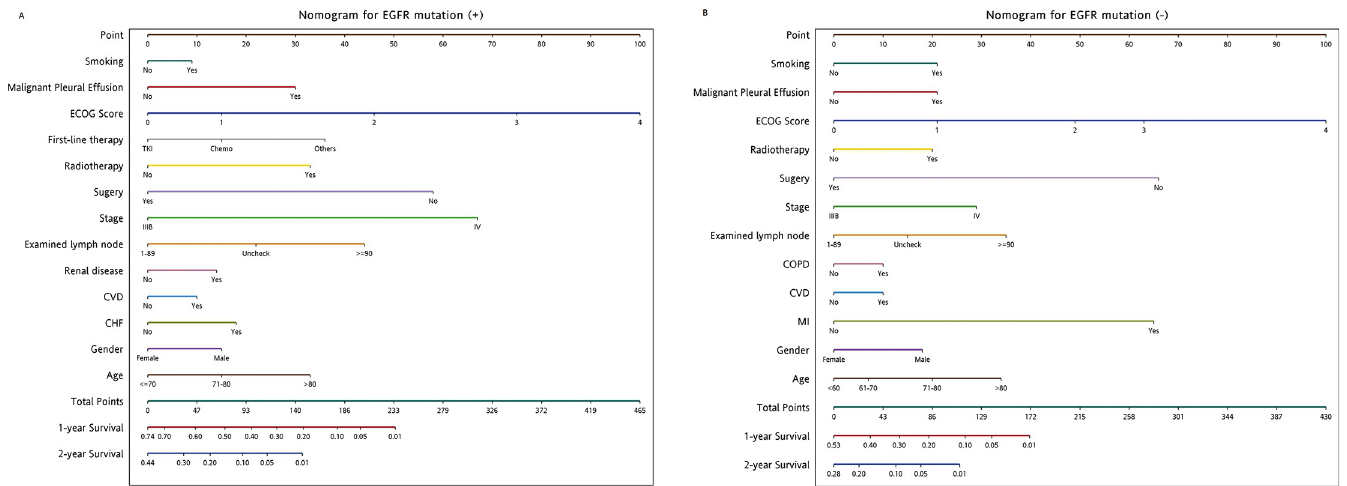
Fig 1. Prediction probability nomograms (1-year and 2-year). (A) EGFR mutation positive (EGFR(+)) patients. (B) EGFR wide-type (EGFR(-))